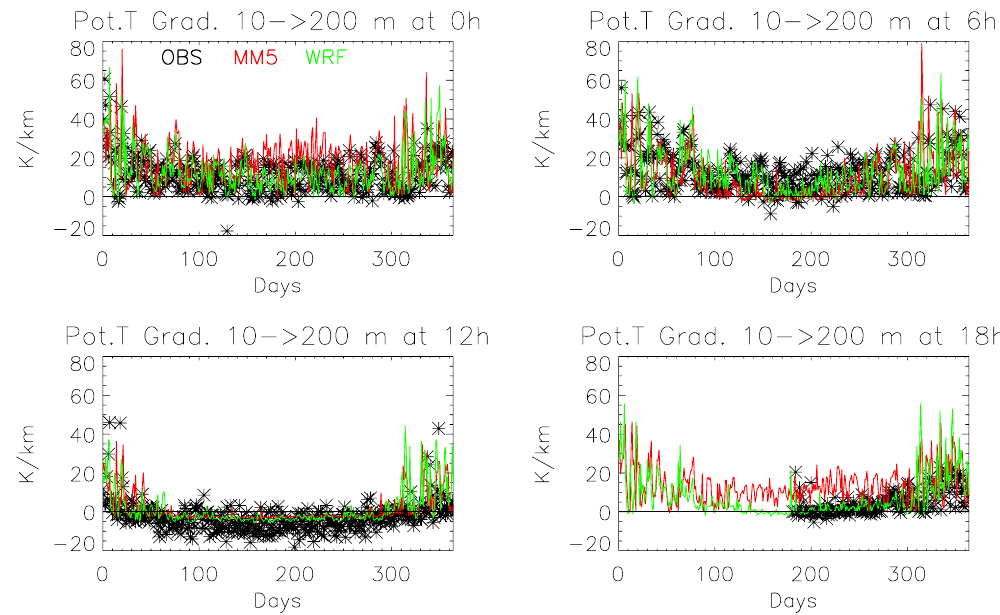
Fig. 3a. Vertical potential temperature gradient profiles between 10m–200m by WRF, MM5 for the Linate airport, together with the observations for 00:00h, 06:00h, 12:00h and 18:00h for the whole year.